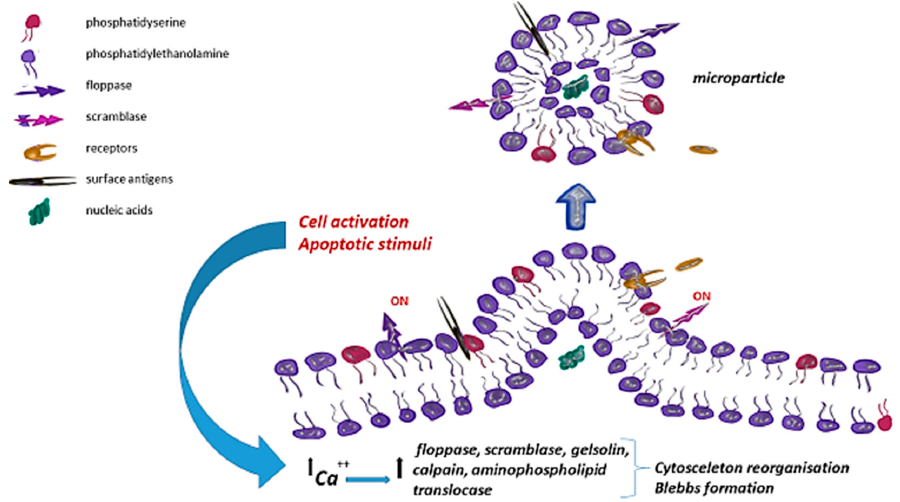
Figure 1. Microparicle formation following cellular activation and cytoskeletal.